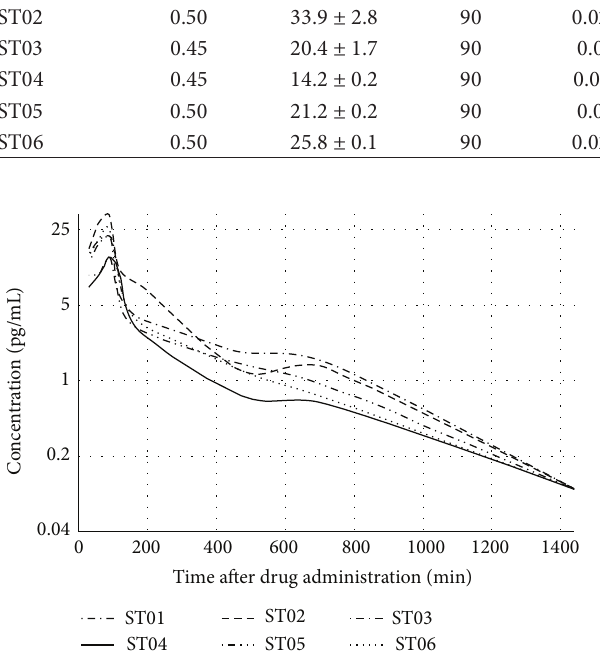
Figure 6: Concentration-time tracking curve of the observed in rabbit plasma stephaglabrine after intramuscular administration.